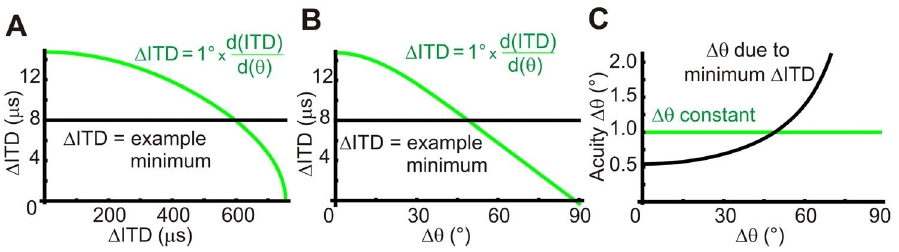
Figure 5. The effect of minimal available D ITD on acuity. Just-noticeable differences in ITD identification ( D ITDs) required to produce the same acuity (1 u ) at all angles, shown for the time domain ( A ) and angular domain ( B ). This is compared to an example of the minimum possible D ITD available in the ITD identification system (across all ITDs). At some point across the range, the minimum D ITD is greater than the D ITD required for constant acuity, leading to poorer acuity laterally than at the midline ( C ). The crossover point depends both on the maximum sensitivity of the system (minimum D ITD) and the value of constant acuity.